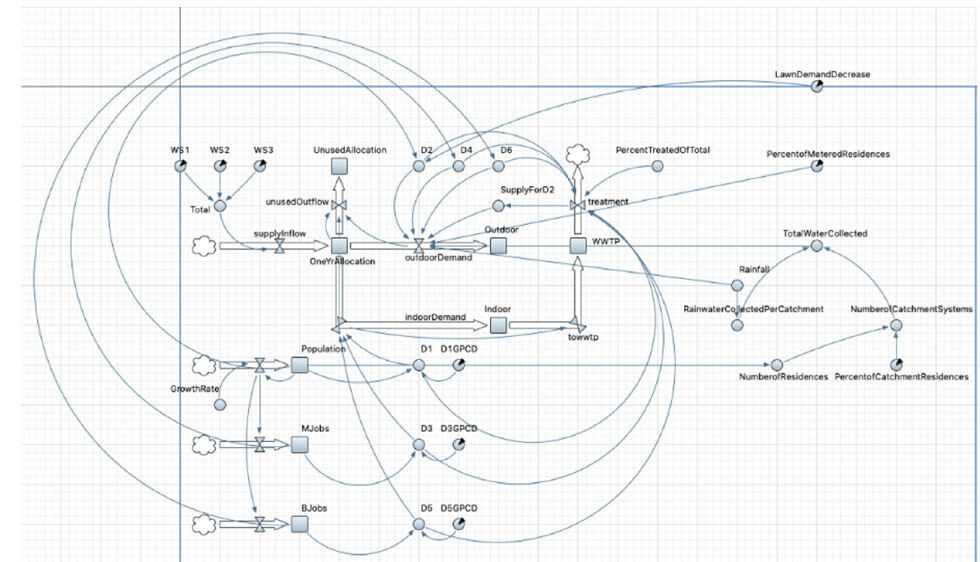
Figure 3. System Dynamics Model of the Water System in Boerne, Texas.